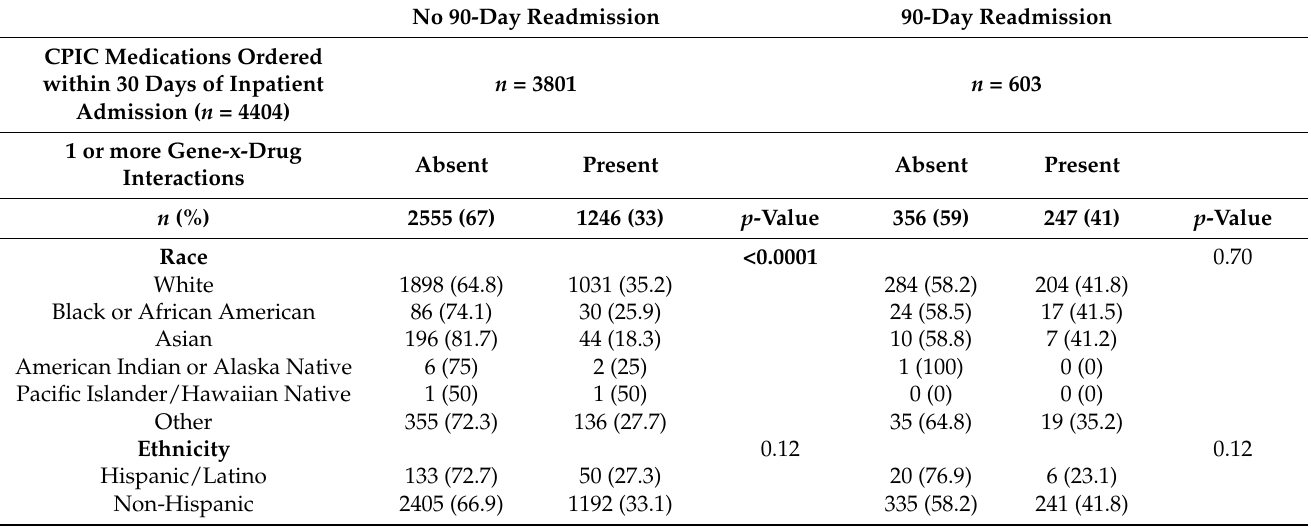
Table 3. Identified Gene-x-Drug Interactions by Race/Ethnicity and 90-day Hospital